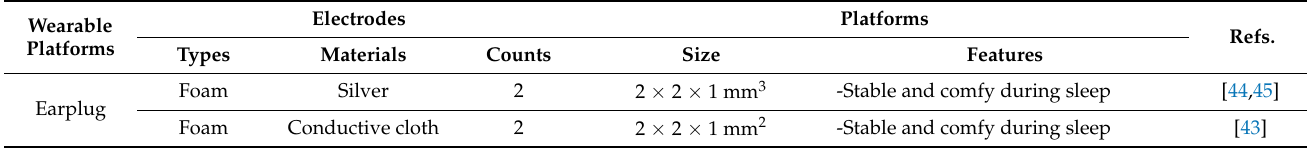
Table 2. Summary of wearable EOG